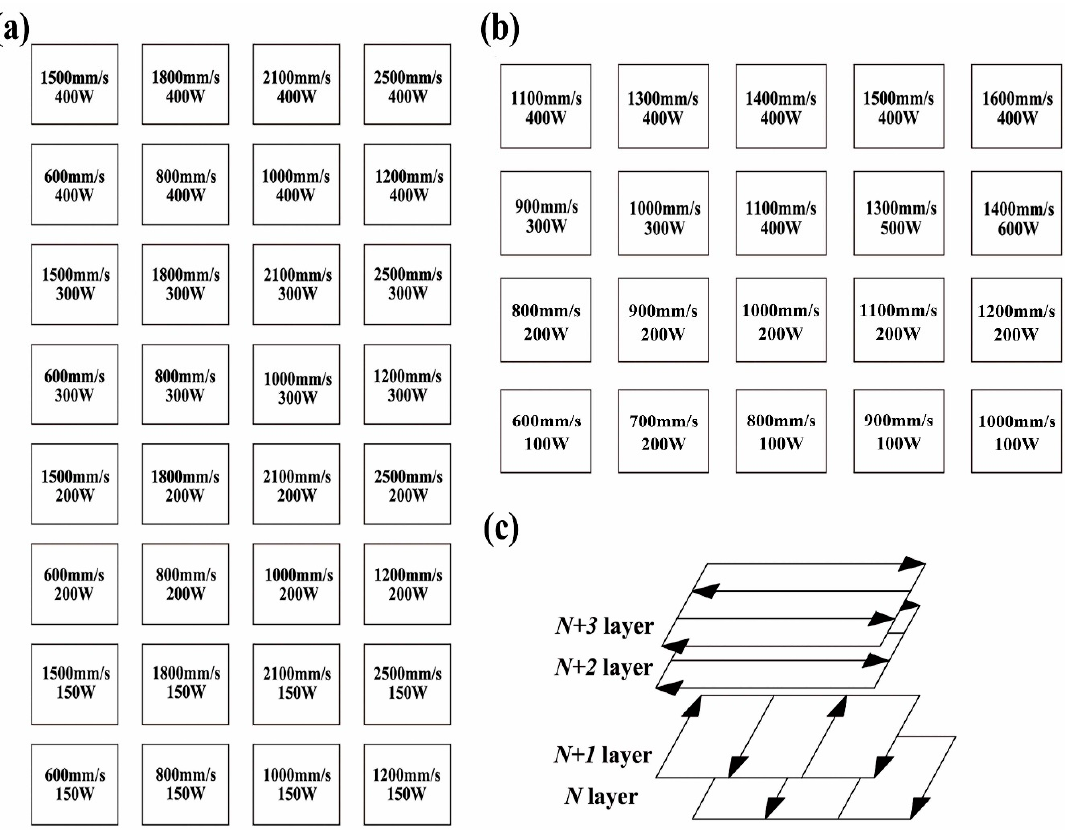
Figure 2. Setting parameters for SLM fabrication of Ti6Al4V: ( a ) Fabricating parameters for stage (I); ( b ) fabricating parameters for stage (II); ( c ) principles of S-shaped normal scanning.